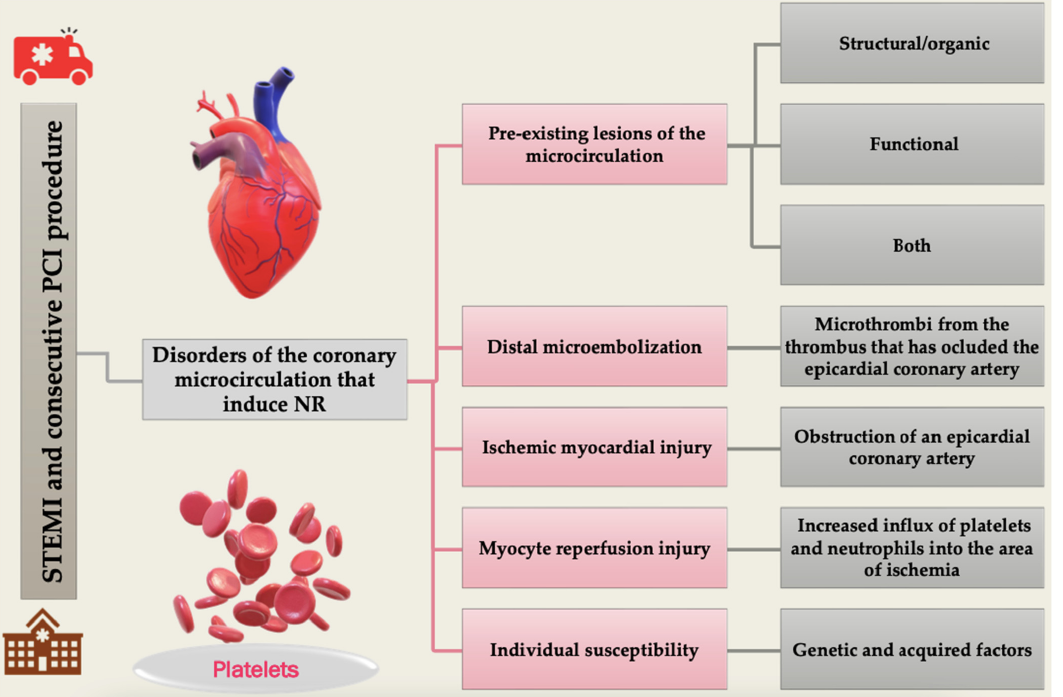
Figure 2. The main pathophysiological mechanisms involved in no-reflow (NR) apparition in STEMI after PCI, mainly occurring because of pre-existing lesions or other favoring factors, or wors- ened by the procedure itself. PCI, percutaneous coronary intervention; STEMI, segment elevation myocardial